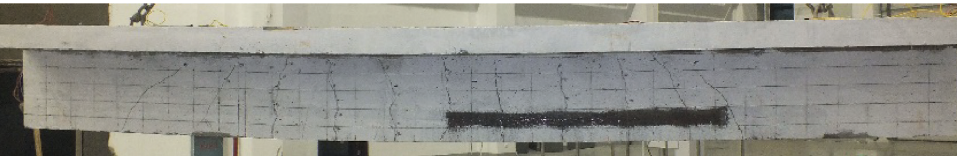
Figure 9: Loading test.